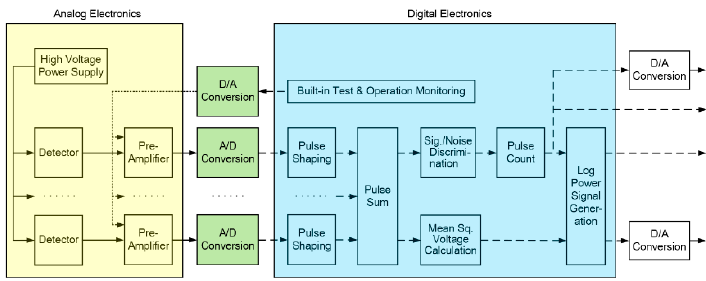
Figure 2. Block diagram of the proposed digital logarithmic power signal generation.